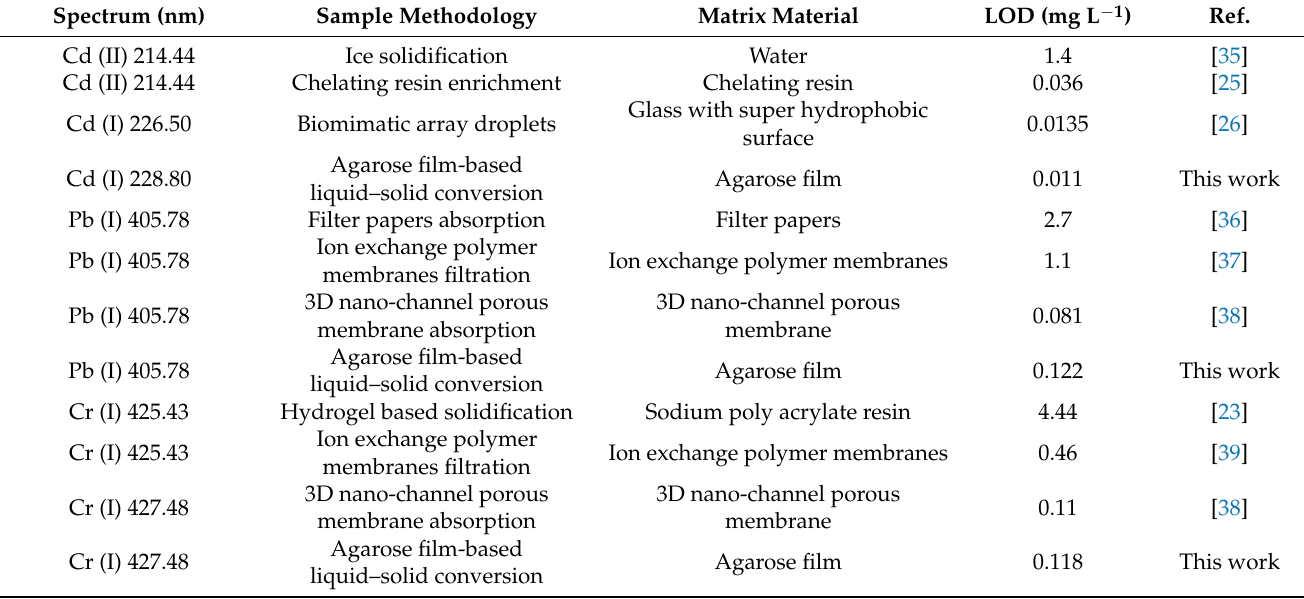
Table 1. Comparison of the limit of detection (LOD) of Cd, Pb and Cr using different techniques for water